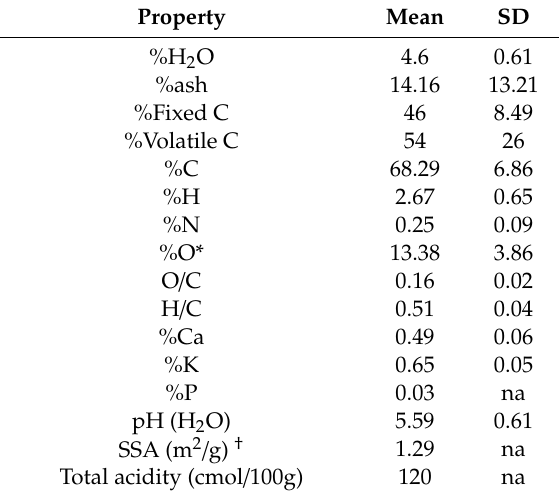
Table 1. Characteristics of hardwood biochar (oven dry basis, SD = standard